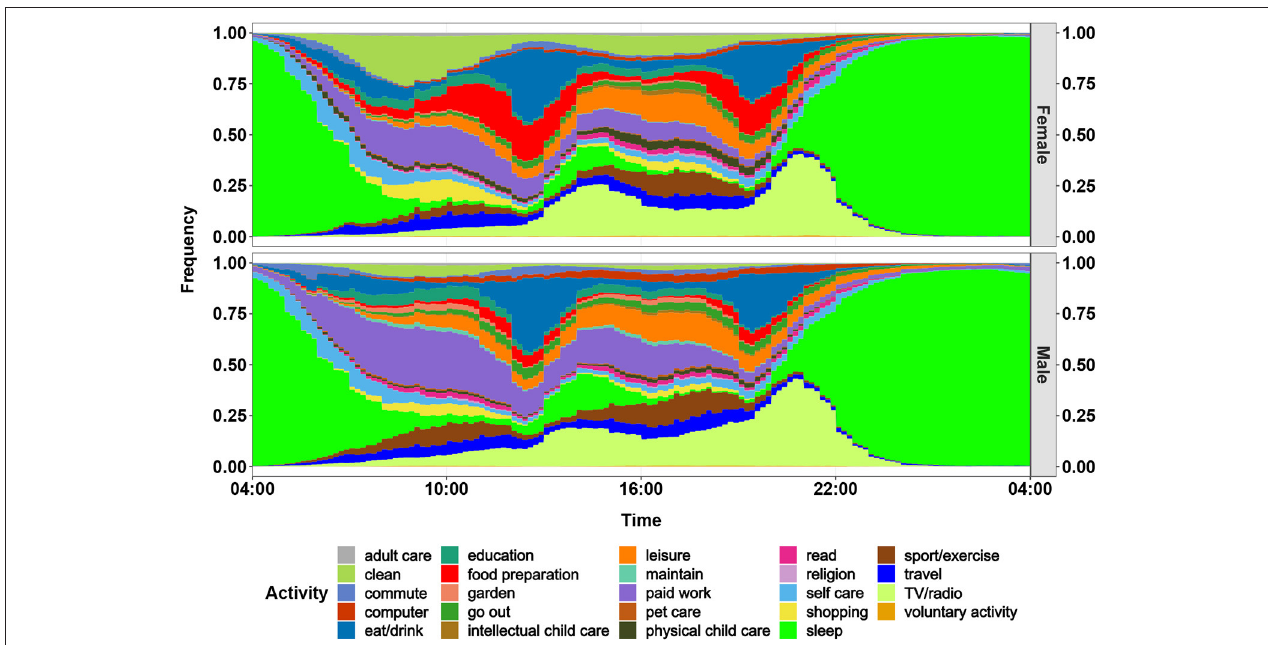
FIGURE 2 | Daily activity profiles of females and males in Spain for 2010. The profiles (diaries) begin at 04:00 and end at 04:00 the next day. This figure displays the frequency of carrying out an activity for women and men for each minute of a day.